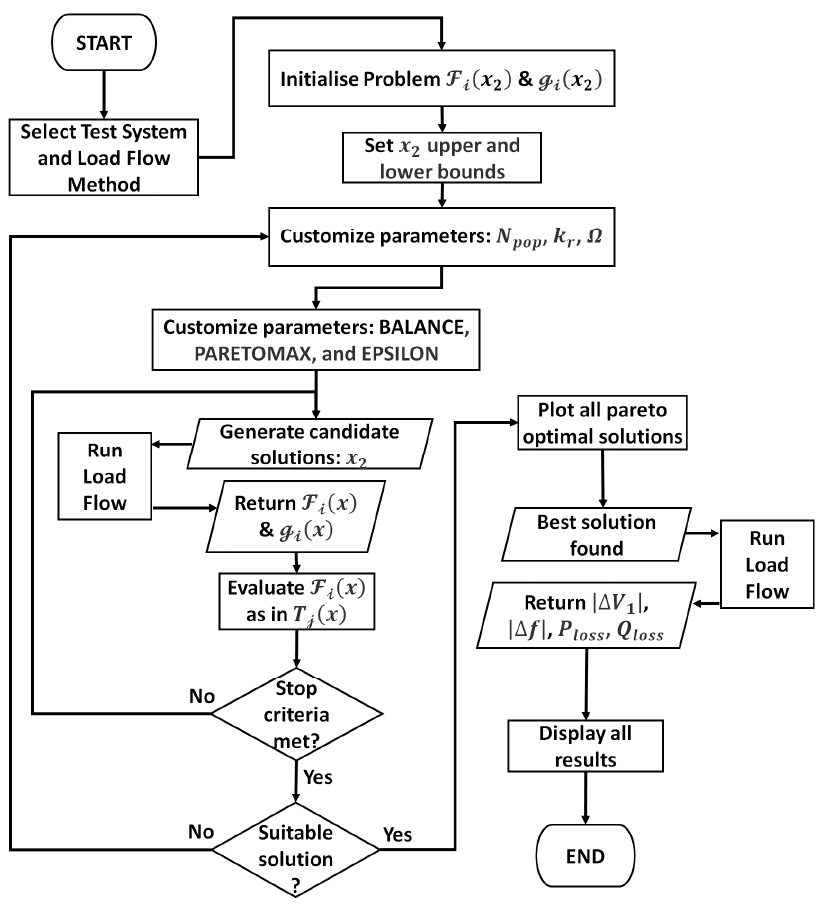
Figure 6. Proposed optimization method flow chart.